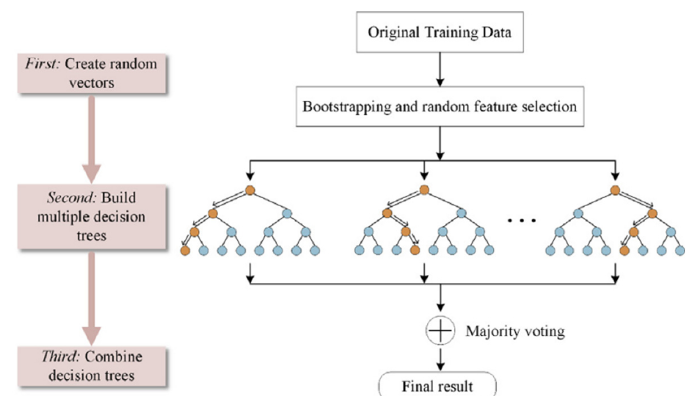
Figure 6. Illustration of the random forest method [29]. Reprinted from Travel Behaviour and Society ,